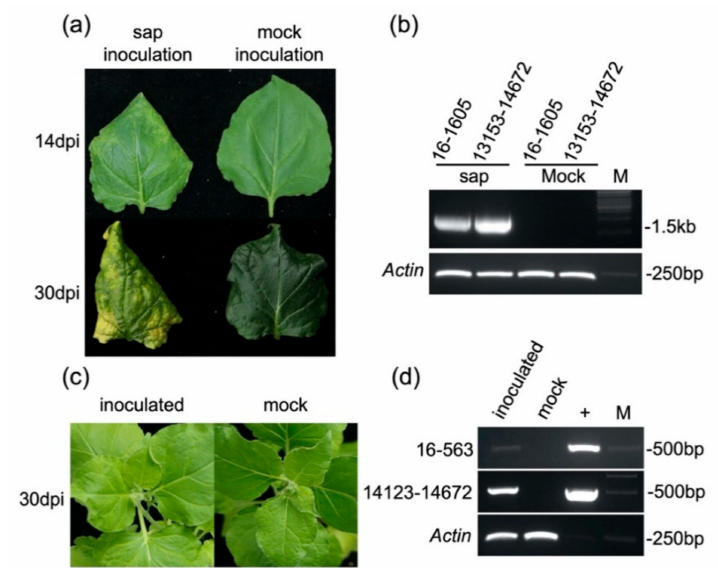
Figure 4. Symptoms on leaves of Nicotiana benthamiana infected by FLRaV: ( a ) Curly leaves and chlorotic spots on the upper leaves of N. benthamiana infected by sap inoculation at 14 and 30 dpi, respectively; ( b ) RT-PCR detection of FLRaV in upper leaves of inoculated N. benthamiana plants with two di ff erent primer pairs specific for two regions of the FLRaV genome indicated above the lanes. Samples were taken at 30 dpi. ( c ) No visible symptoms are observed on the upper leaves of full-length FLRaV cDNA-inoculated N. benthamiana plants at 30 dpi; ( d ) RT-PCR detection of FLRaV in upper leaves of inoculated N. benthamiana plants with two di ff erent primer pairs specific for two regions of the FLRaV genome. Samples were taken at 30 dpi. Recombined plasmid containing the FLRaV cDNA serves as a positive